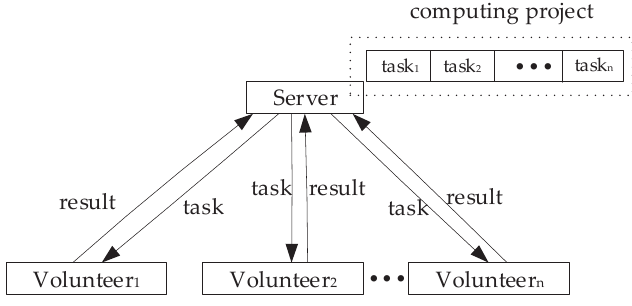
Figure 1. Master-worker